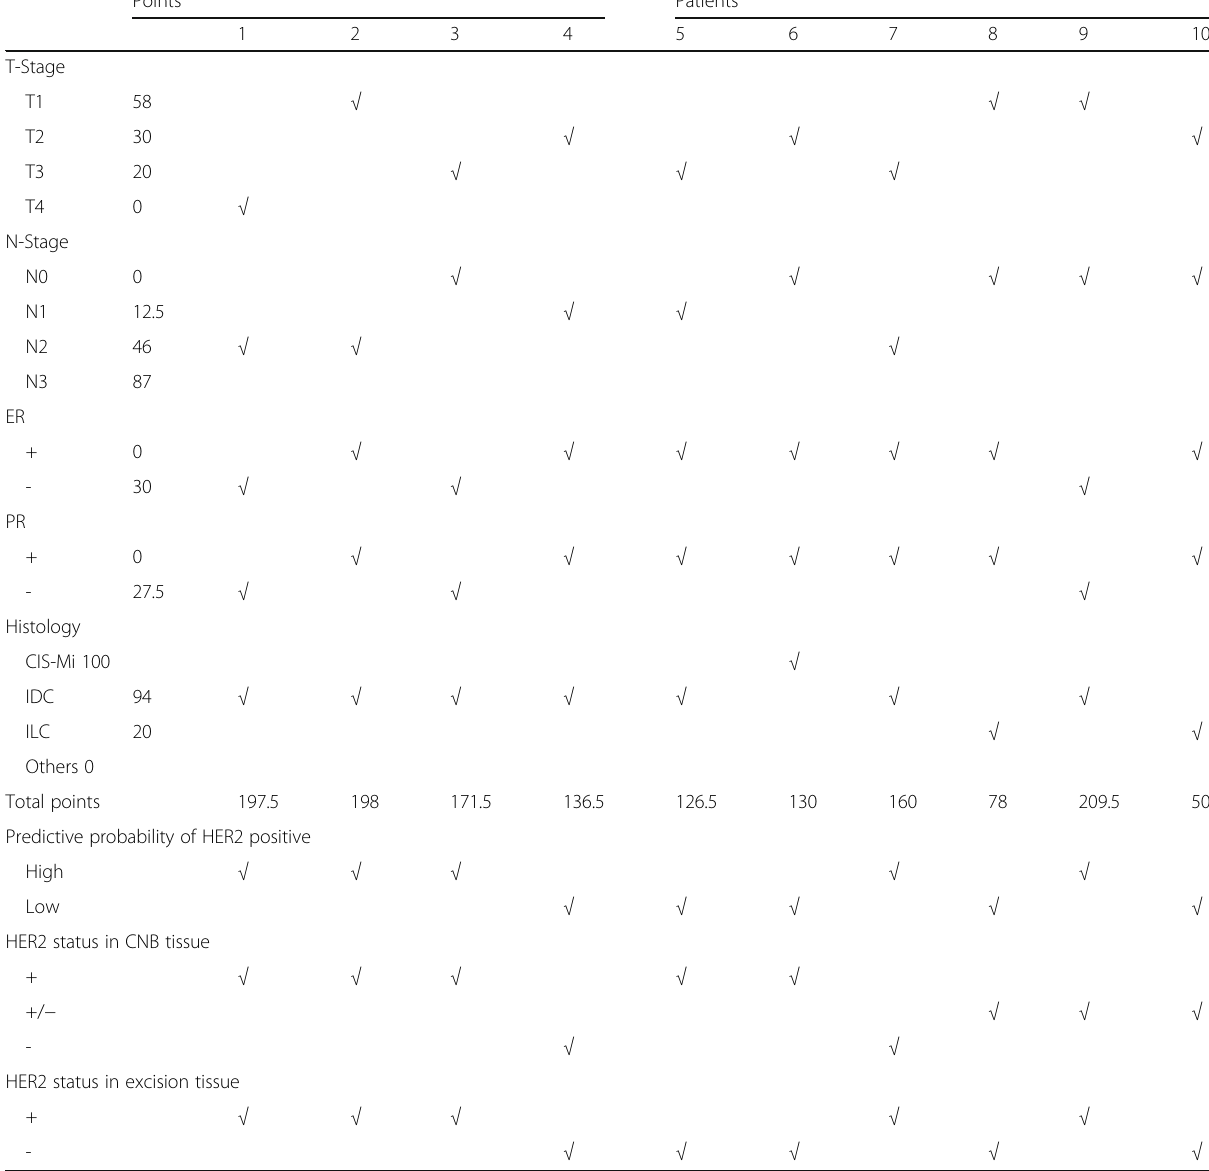
Table 5 The application of the nomogram